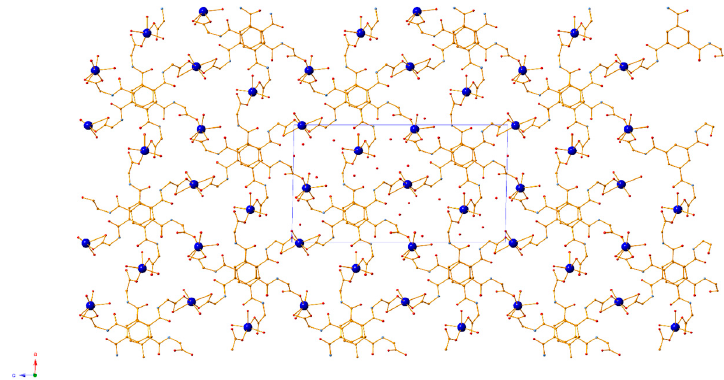
Figure 2. Packing diagram for 1 along the a0c plane.